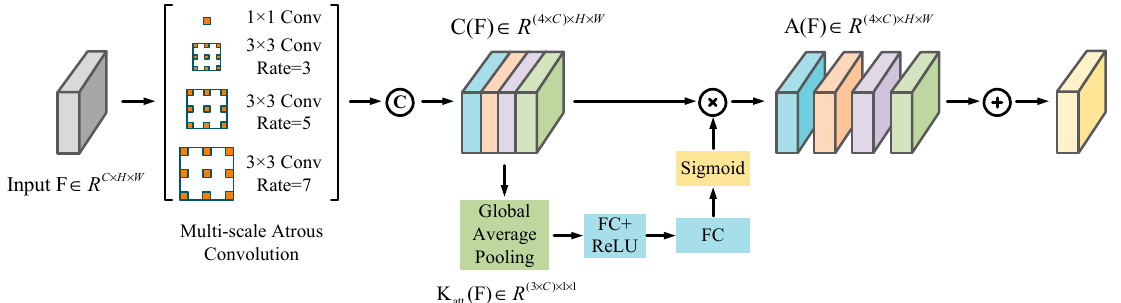
Figure 4. The architecture of attention-guided context-aware pyramid feature extraction (ACPFE).